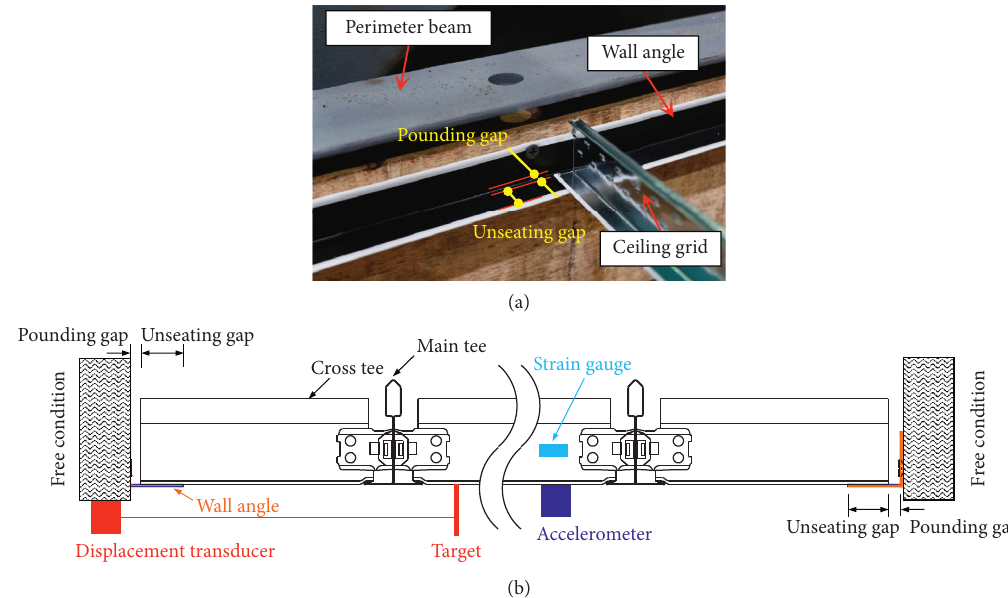
Figure 2: Free condition at boundary. (a) Connection and (b) details of